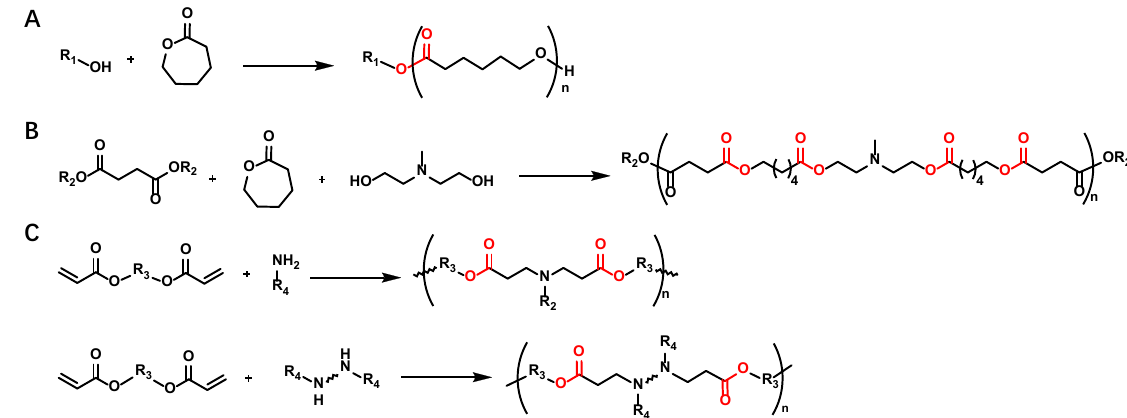
Figure 4. Synthesis of the ester-containing polymers via either ROP (A and B) or stepwise-growth polymerization, e.g., Michael addition reaction (C)